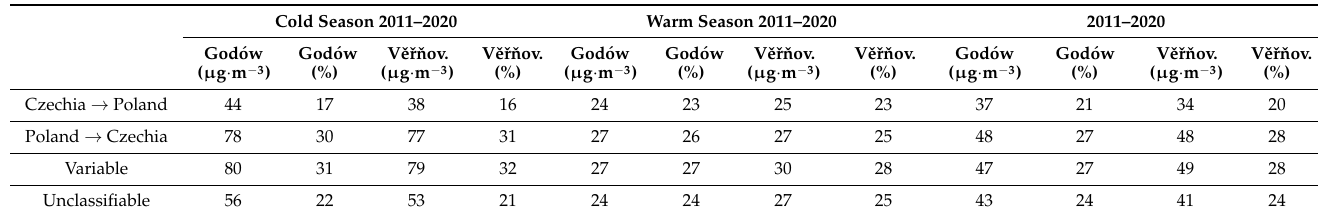
Table 2. Quantification of transboundary PM 10 transmission between the Czech Republic and Poland